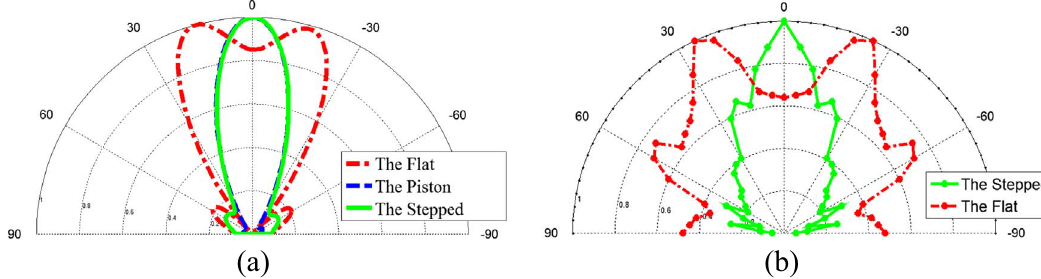
Figure 9. The directivity patterns of the square plate radiators. (a) The calculated, (b) the measured. Table 1. Relation among the frequency, nodal lines of the rhombus response mode, and geometrical dimensions of the